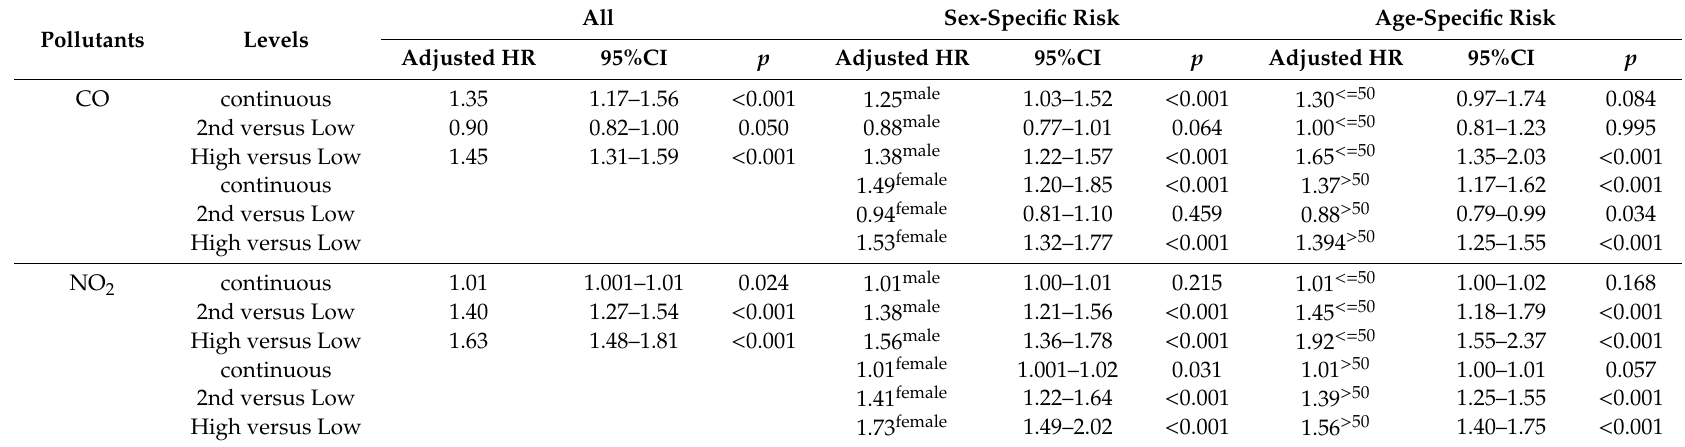
Table 5. Adjusted HR of hearing loss in the moderate and high concentration groups compared to that in the low concentration group.